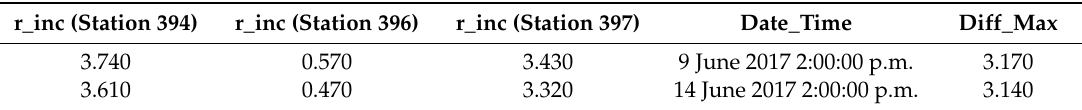
Table 15. Task 5: a cluster of three monitoring stations where the high value of the difference_max on the r_inc attribute indicates a hardware sensor issue from June 2017 for the station 396.